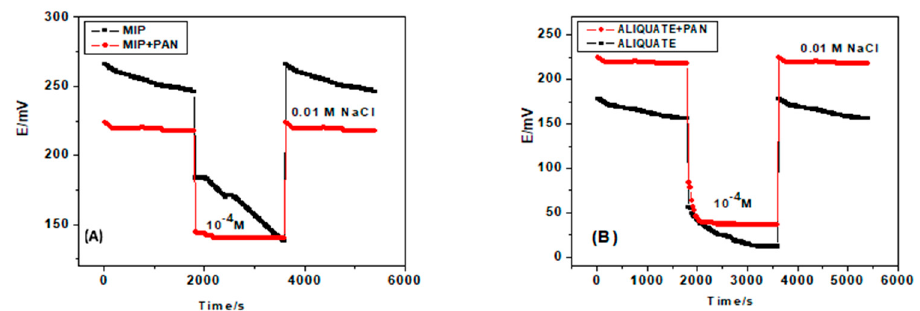
Figure 6. Water layer tests for flucarbazone ISEs based on ( A ) MIP; and ( B ) Aliquat.